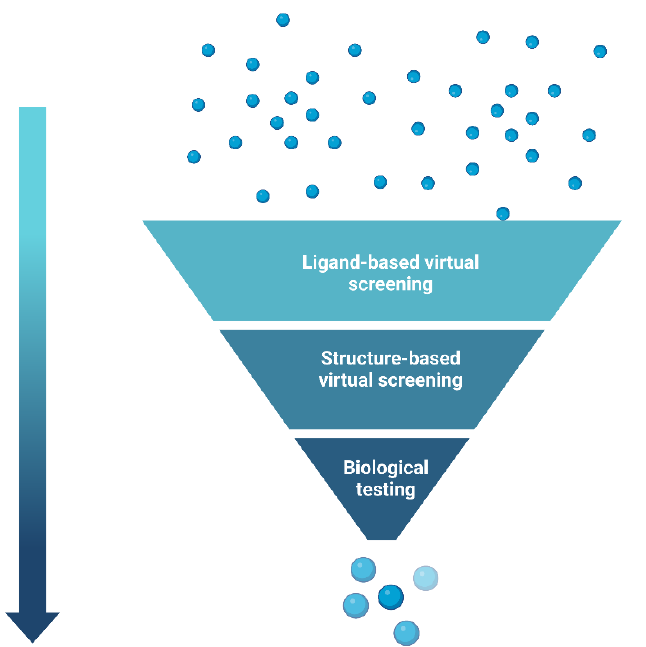
Figure 13. HLVS approach. A series of filters are sequentially applied to a database of small molecules to reduce the number of molecules to be taken to biological testing and extract lead compounds for further investigation and optimisation.